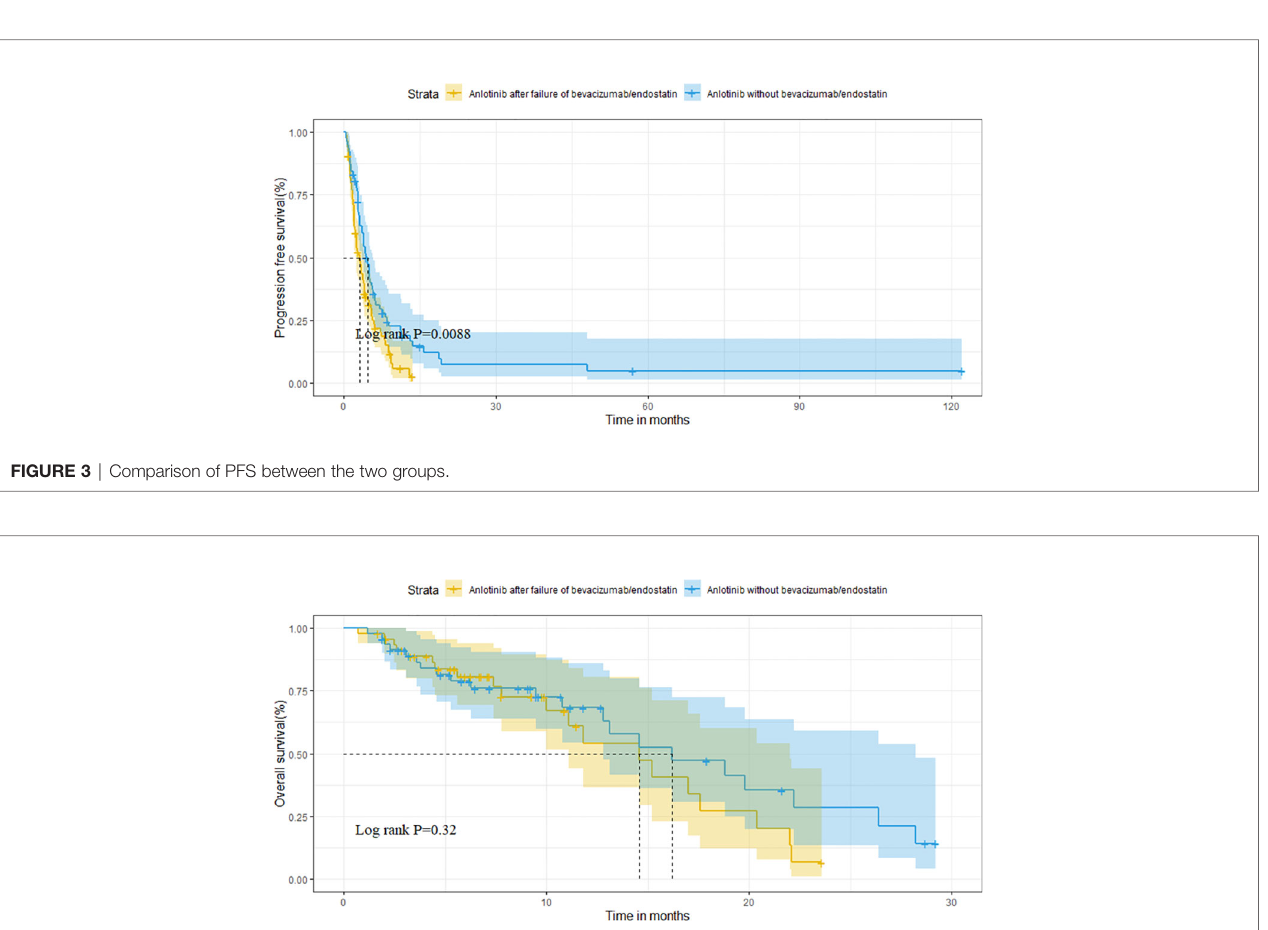
FIGURE 2 | Comparison of OS between the two groups.